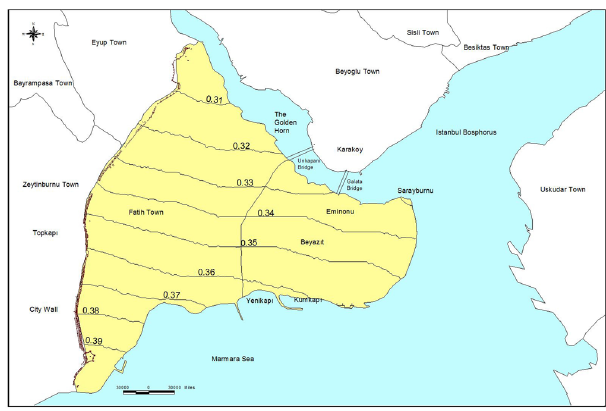
Fig. 10. PGA contour map for a 10% probability of exceedance in